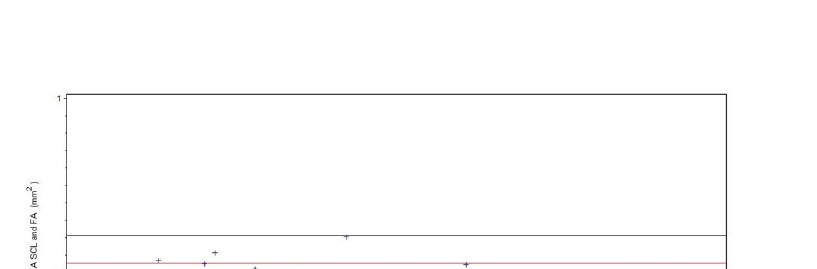
Fig 4. FAZ: Bland-Altman-Plot for the agreement of FA and OCTA DCL for all patients.